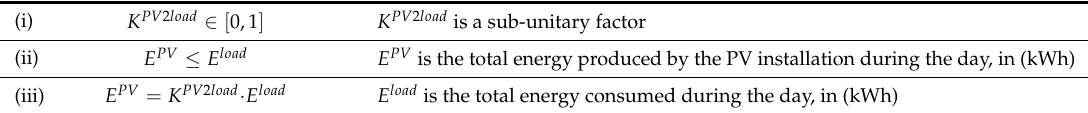
Table 2. Mathematical explanation of the proposed Uni-directional Resilient Consumer (UniRCon )